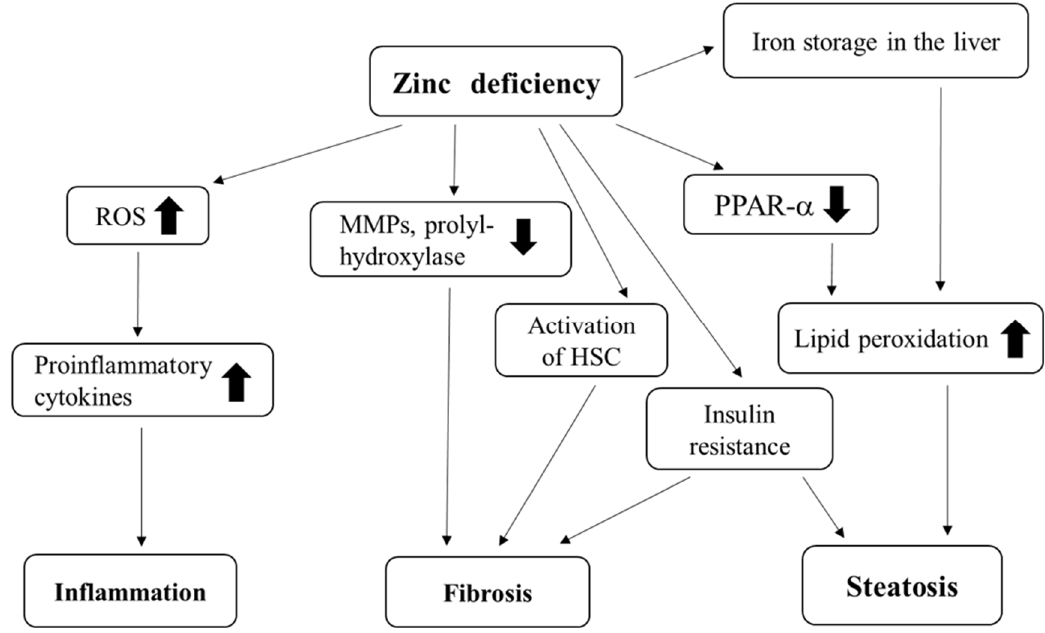
Figure 1. Relationship between zinc deficiency and inflammation, fibrosis or steatosis in the liver. ROS: Reactive oxygen species; MMP: Metalloproteinase; PPARα: Peroxisome proliferator-activated receptor-α; HSC: Hepatic stellate cell; ⬆ : Promotion; ⬇ : Inhibition.